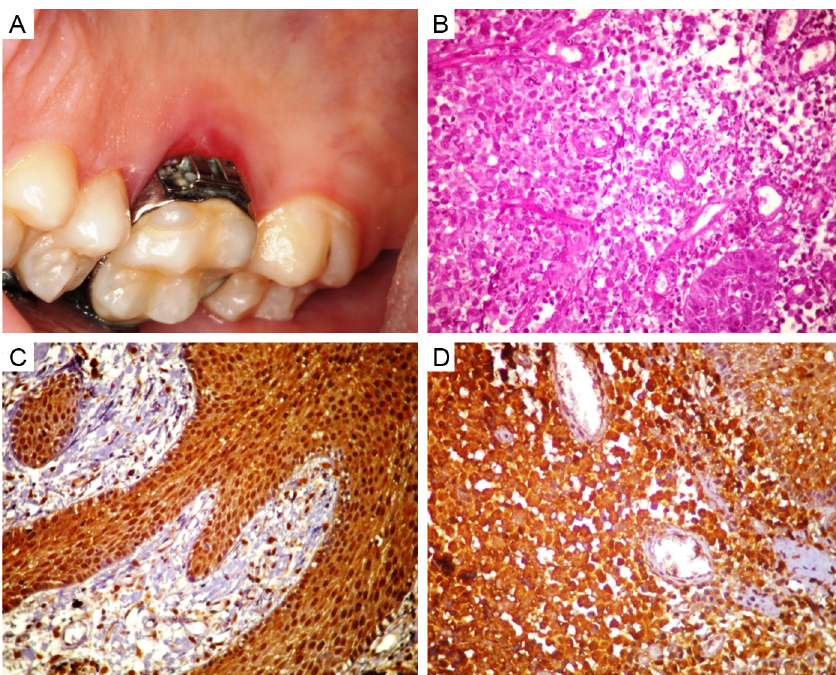
Figure 1 (A) Intraoral clinical imaging showing red ulcerated lesion in the palatal gingiva, adjacent to the first upper molar. (B) Microphotograph showing neoplastic lesion characterized by polygonal cells, at times exhibiting granular cytoplasm among numerous blood vessels, and inflammatory infiltrate consisting of lymphocytes, neutrophils, and eosinophils (HE × 400). (C) Immunohistochem- ical findings positive for S100 ( × 200). (D) Immunohistochemical findings positive for CD1A ( × 400). The clinical features of LCH are similar to several con- ditions, including periodontal disease, malignancies such as squamous cell carcinoma or lymphoma, as well as granulo- matous or ulcerative lesions that are characteristic of fungal infections. 2 Thus, a thorough assessment is appropriate for oral cavity lesions that persist after treatment. In the oral cavity, it usually presents as a mucosal ulcer associated with underlying bone lesions, 6 which was not observed in this